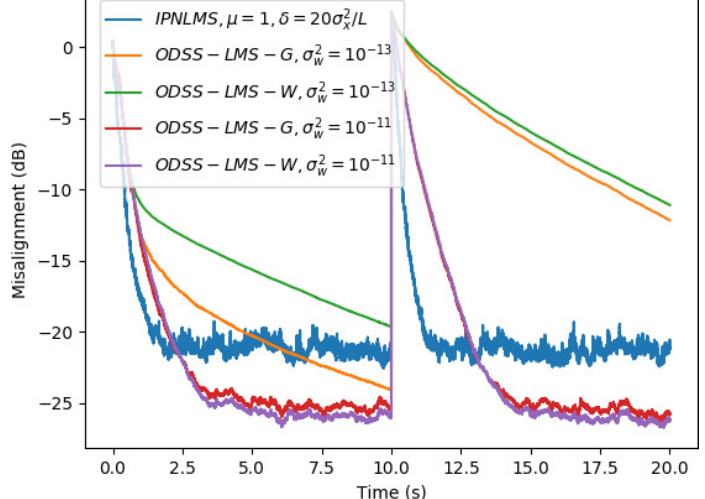
Figure 7. Normalized misalignment of the IPNLMS, ODSS-LMS-G, and ODSS-LMS-W algorithms for different values of σ 2 w . Echo path changes at time 10 s. The input signal is an AR(1) process, with β = 0.9, L = 512, and SNR = 20 dB. The unknown system is the acoustic echo